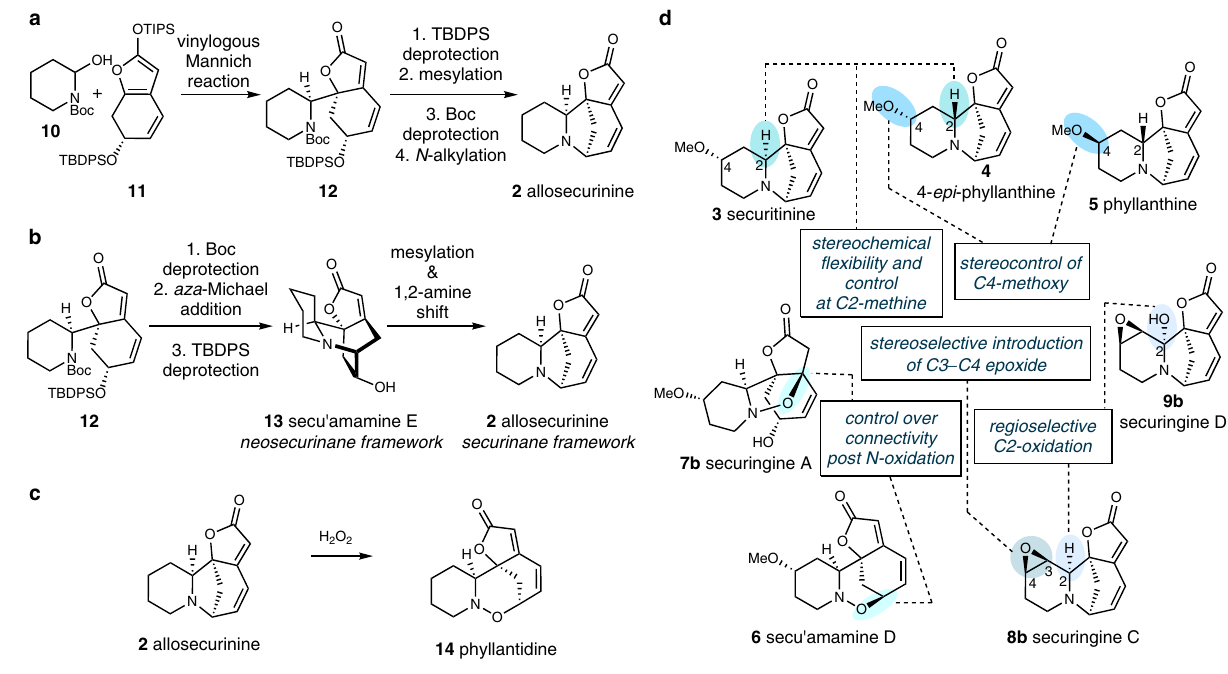
allosecurinine (ref. 22); c Horii and Parello ’ s biomimetic conversion of allosecur- inine to phyllantidine (ref. 23); d Pre- and post-modi fi cation of the securinega